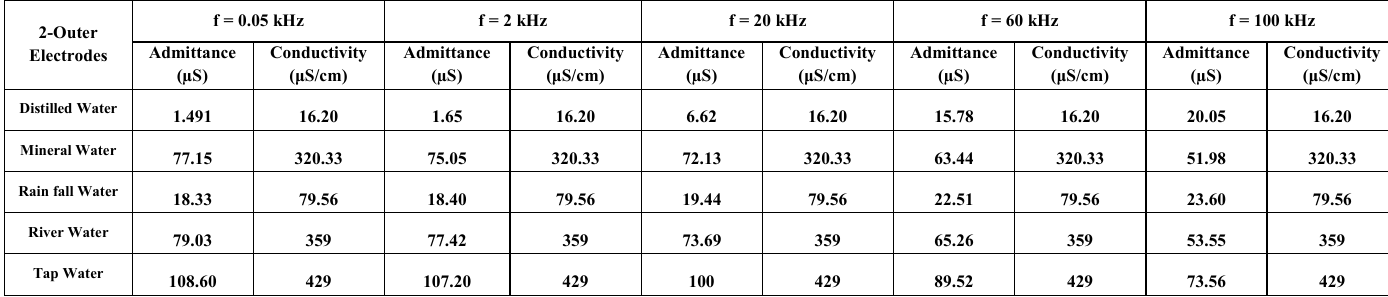
Table (3) calculated values of admittance and measured conductivity for different frequencies by the 2-outer electrode system f = 0.05 kHz 2-Outer Electrodes